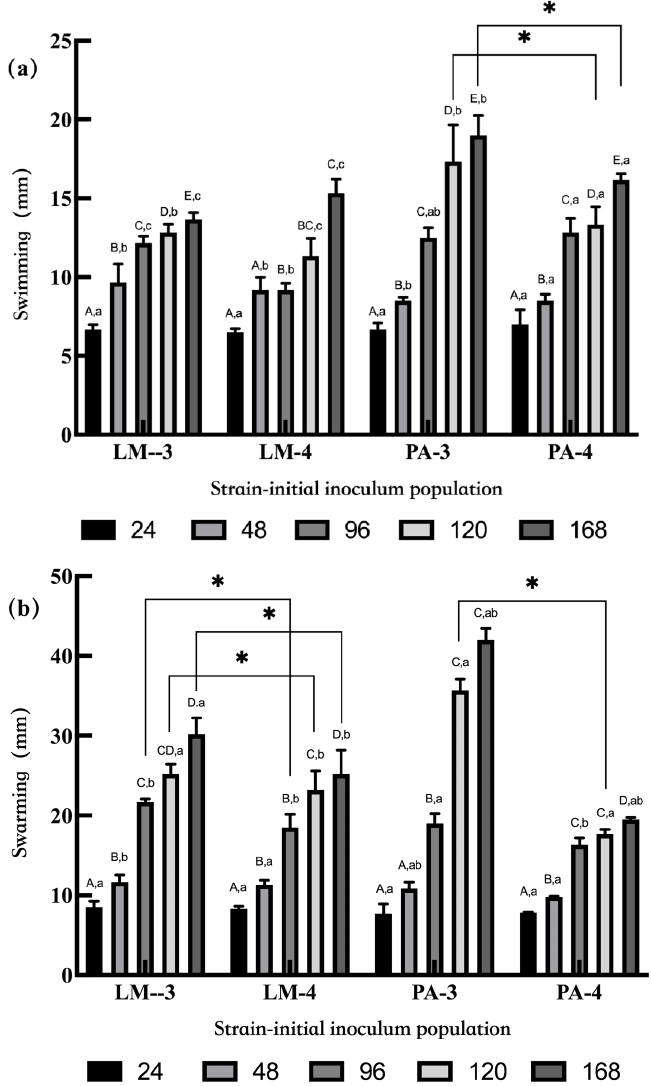
Figure 5. The motility of L. monocytogenes and P. aeruginosa in different populations and incubation times. Note: ( a ) swimming ability and ( b ) swarming ability. Capital letters (A–D) indicate a significant difference ( p < 0.05) within different incubation times in the same group. Lowercase letters (a–c) indicate a significant difference ( p < 0.05) within the same incubation time between LM-3 and PA-3 or LM-4 and PA-4 groups. The asterisks indicate a significant difference ( p < 0.05) between LM-3 and LM-4 or PA-3 and PA-4 groups.